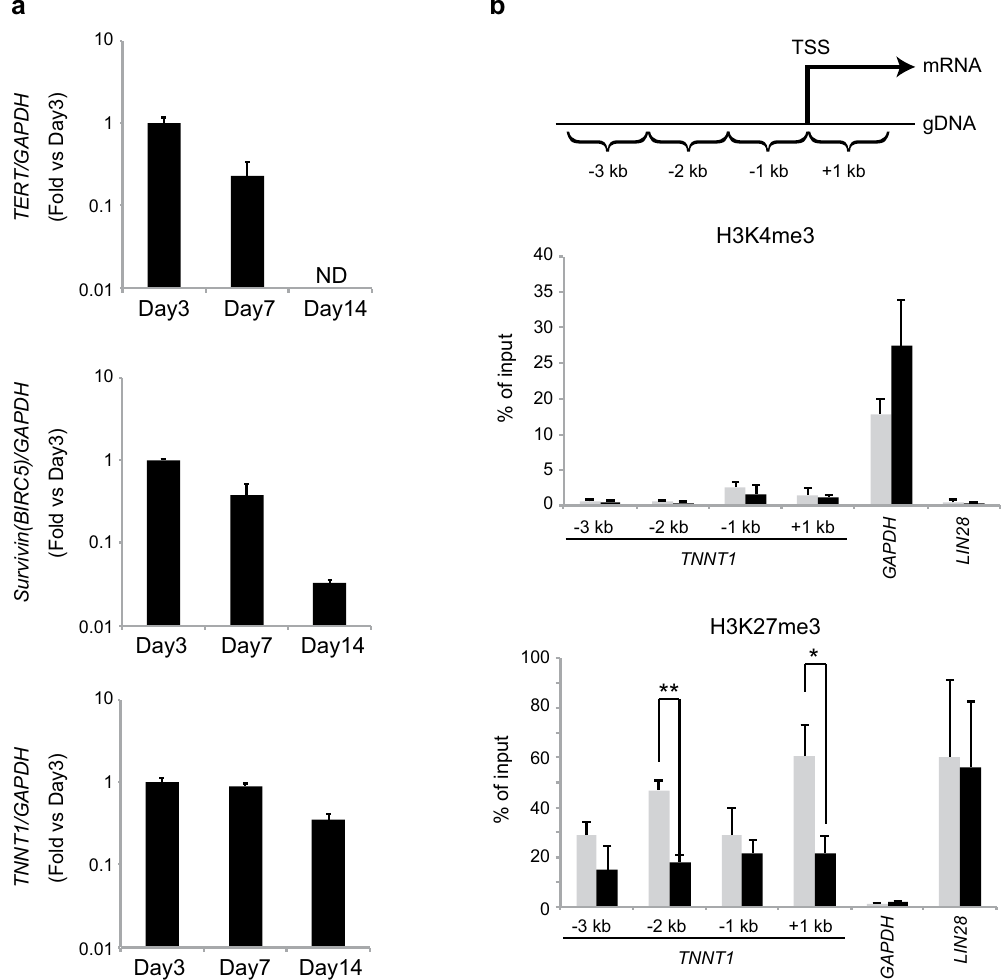
Figure 3. Time course analysis of TNNT1 mRNA expression and ChIP-qPCR assay of the transcription start site of TNNT1 . (a) Time course of the expression of TERT , Survivin/BIRC5 , and TNNT1 mRNA in primary RPE cells during culture for 3, 7 and 14 days as analyzed by qRT-PCR. Bar graph represents fold gene expression relative to day 3. (b) ChIP-qPCR assay of H3K4me3 and H3K27me3 in − 3 kb, − 2 kb, − 1 kb, and + 1 kb regions from the TSS of TNNT1 . Positive control experiments were performed with promoter regions of GAPDH (H3K4me3) and LIN28 (H3K27me3). Results are means ± standard deviations of three independent experiments (black; ARPE-19 cells, gray; primary RPE cells). ND: not detected. * P < 0.05, ** P < 0.01, Student’s t -test (n = 3).